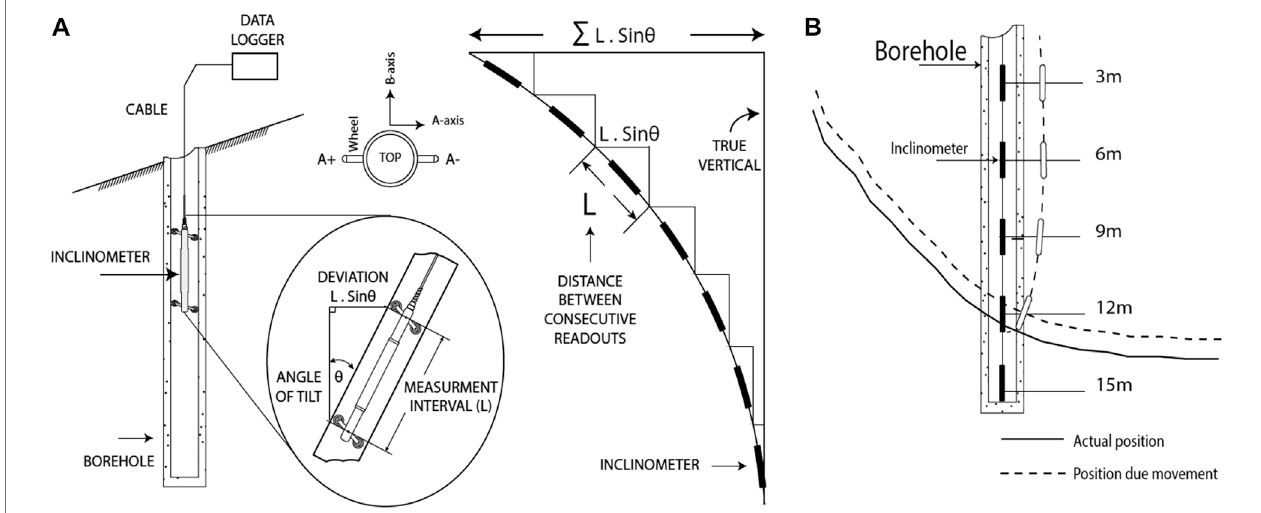
FIGURE 2 | (A) The inclinometer sensor was installed in the borehole at the landslide location. (B) The analysis of the maximum soil movement of inclinometer installed at 12 m depth near the failure plane.